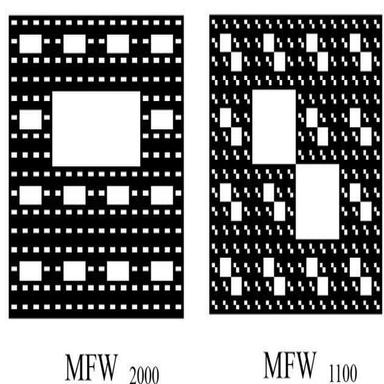
The third-order fractal model of MFW_2000 and MFW_1100.